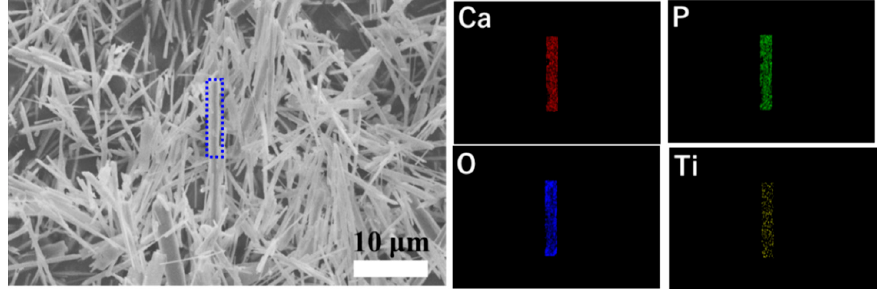
Figure 4. FE-SEM images of TiO 2 -coated HAp particles and component elements detected by EDX local mapping.